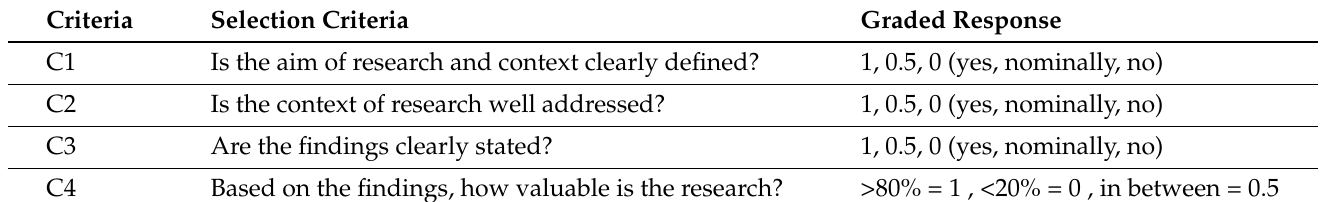
Figure 6. Year-wise distribution of articles. Table 6. Selection criteria versus response graded.